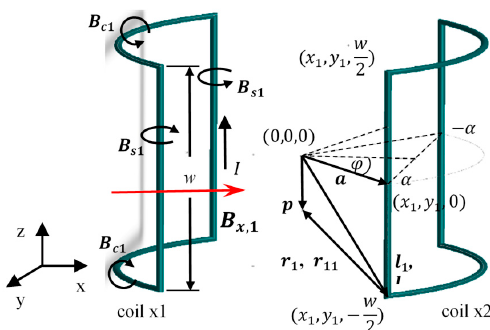
Figure 5. Double bent coils with parameters of magnetic fields generated by four curve and straight wires ( α = 90°). Mathematical development and analysis are in the Appendix A.